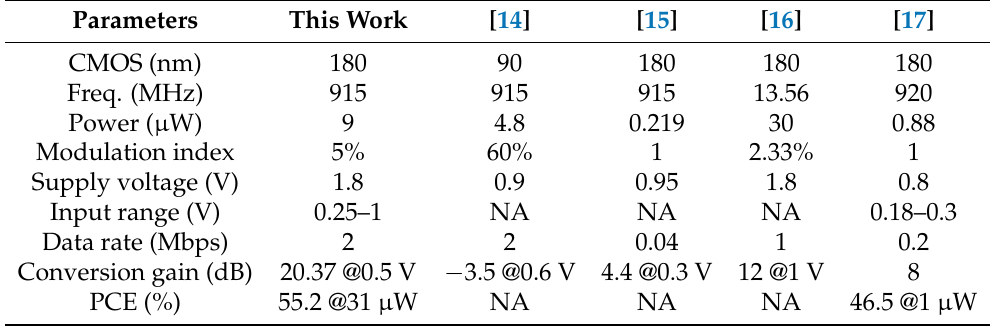
Table 3. Performances comparison of the proposed envelope